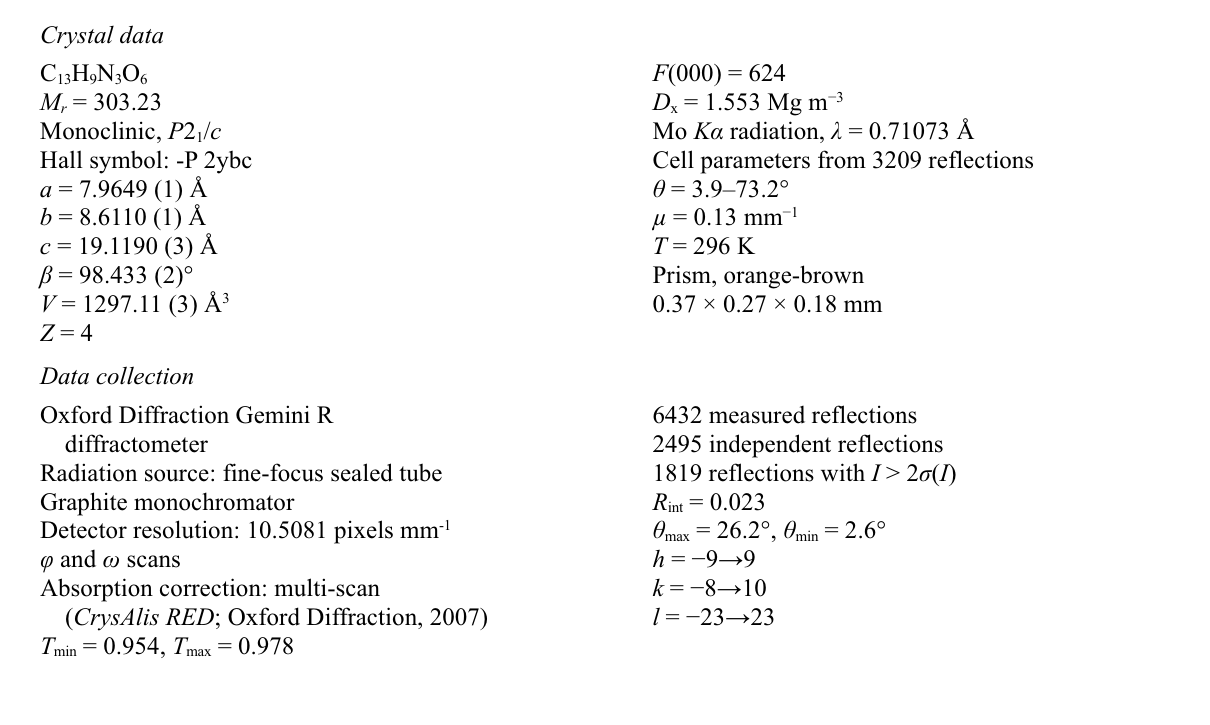
Figure 2 The molecular packing for C and intramolecular N–H···O hydrogen bonds. The predominately occupied (0.64) hydrogen atom (H2O) is shown attached to O2 while H1O at 0.36 occupancy is not